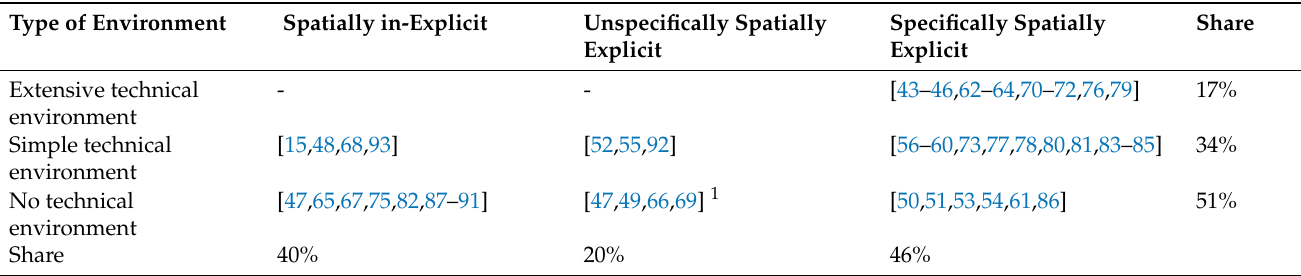
Table 8. Traits of the modeled environments. This table references the specific records, where the models environments are reported on.